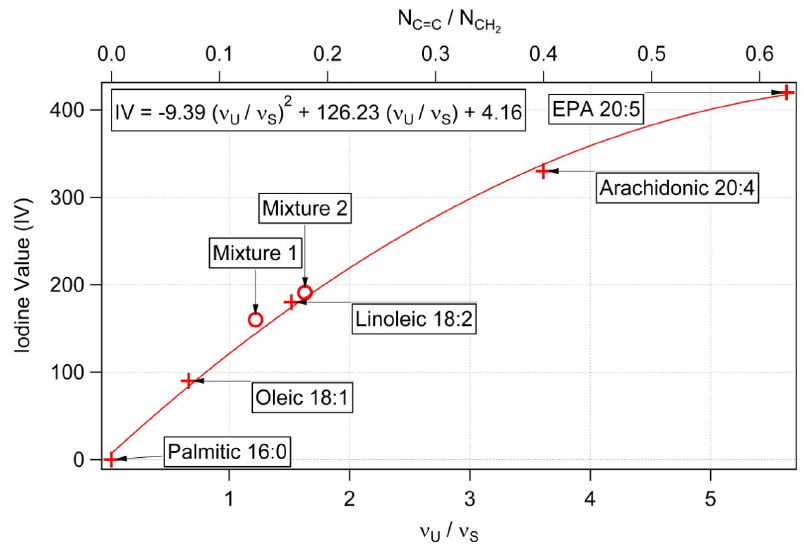
Figure 5. Calibration curve for estimating the iodine value (IV) from the Raman spectral data. The IV range of 0–430 is covered which includes virtually all biologically relevant fatty acids. Crosses mark experimental data obtained with pure fatty acids, continuous line is a parabolic fit of this data. Circles indicate verification data points obtained with mixtures of oleic and arachidonic acids of different molar ratios; this data was not included in the fit. Formula given in the top left corner of the graph was used for calculating IV of the studied algae from experimental spectroscopic